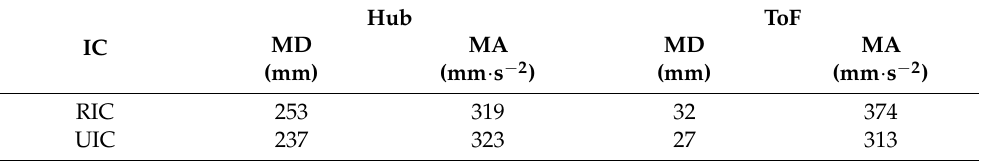
Table 7. The responses of the OWT under UIC and RIC.